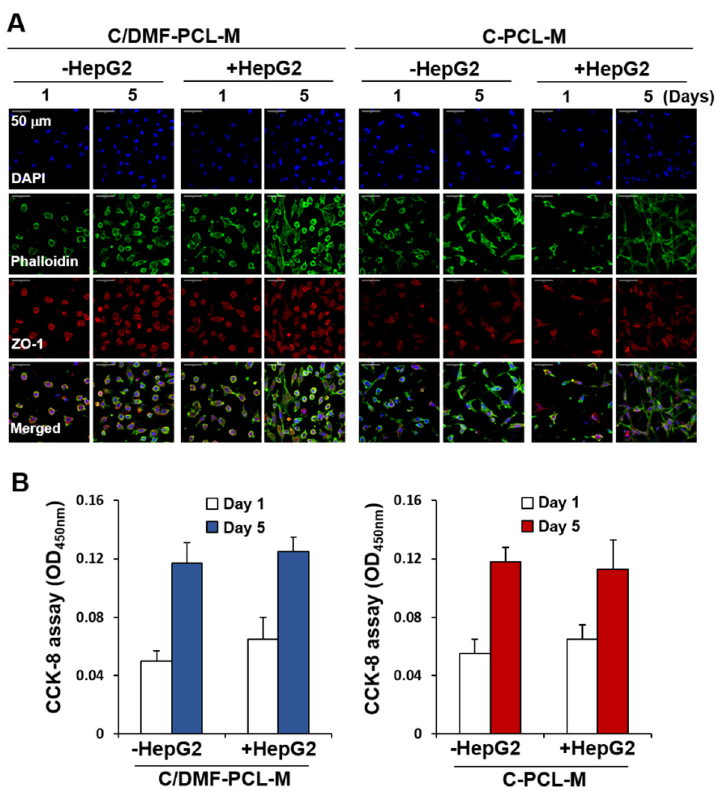
Figure 5. Growth of EA.hy926 ECs co-cultured with HepG2 cancer cells on C/DMF-PCL-M and C-PCL-M in a two-layer culture system. EA.hy926 cells (3 × 10 4 ) were top-seeded on either C/DMF-PCL-M or C-PCL-M in the upper layer and cultured with (+HepG2) or without ( − HepG2) HepG2 cells (3 × 10 4 ) on the C-PCL-M in the lower layer. Cells were cultured for the indicated periods ( n = 3). ( A ) Cells were stained with antibodies and cell distribution and morphology were assessed via confocal microscopy. Images represent three fields in each nanofibrous membrane. ( B ) Cell proliferation rates were analyzed using the CCK-8 assay. Data are presented as mean ± SD values ( n = 3).